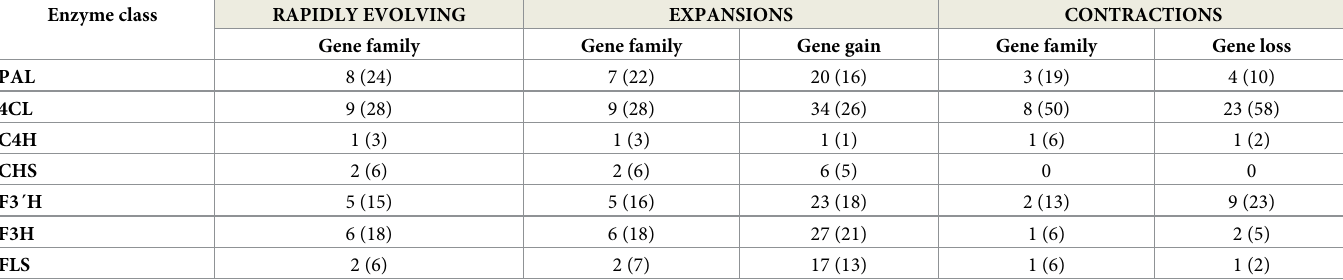
Table 2. Evolution of phenolic gene families across 30 Oenothera taxa as determined by CAFE analysis of seven enzymes; PAL (phenylalanine ammonia-lyase), 4CL (4-coumaroyl: CoA ligase), C4H (Cinnamate 4-hydroxylase), CHS (Chalcone synthase), F3´H (Flavonoid 3´-hydroxylase), F3H (Flavanone 3-hydroxylase) and FLS (Flavonol synthase). We show the total number of gene families that are rapidly evolving (rapid evolution; p -value threshold = 0.01), the number of gene families and genes that have experienced expansions contractions. The percentage per each of the seven phenolic enzymes is shown in parentheses. Enzyme